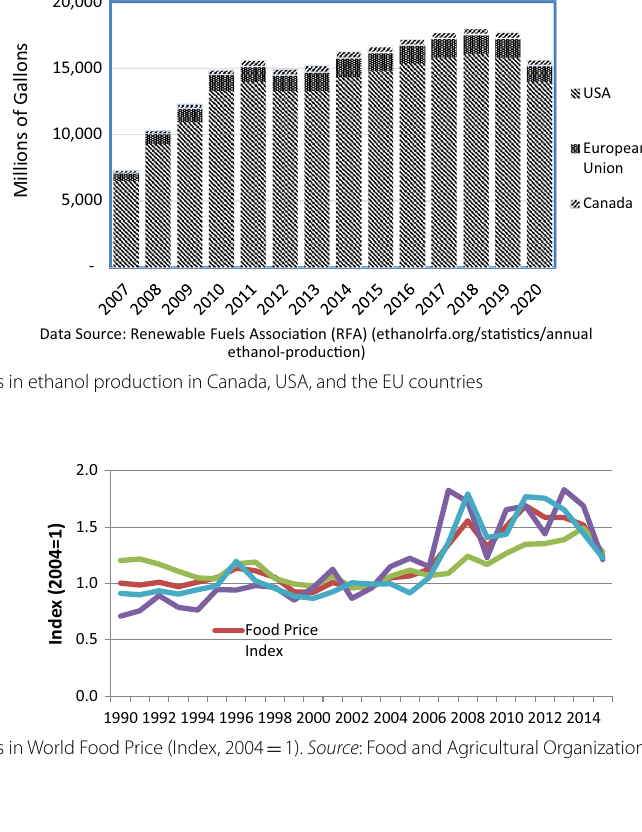
1). Source : Food and Agricultural Organization (FAO) =